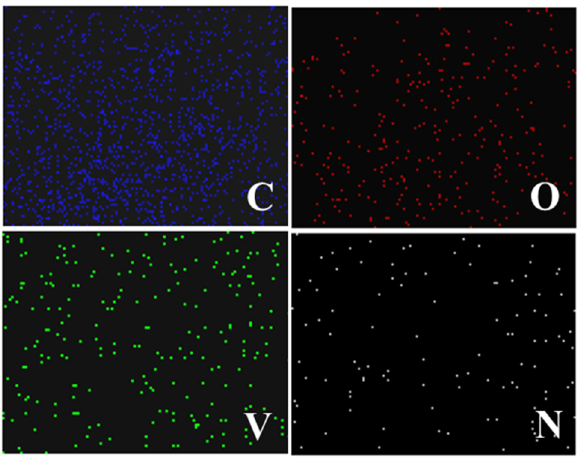
Figure 7. Elemental mapping images of V 2 O 5 / f -CNT/PPy.